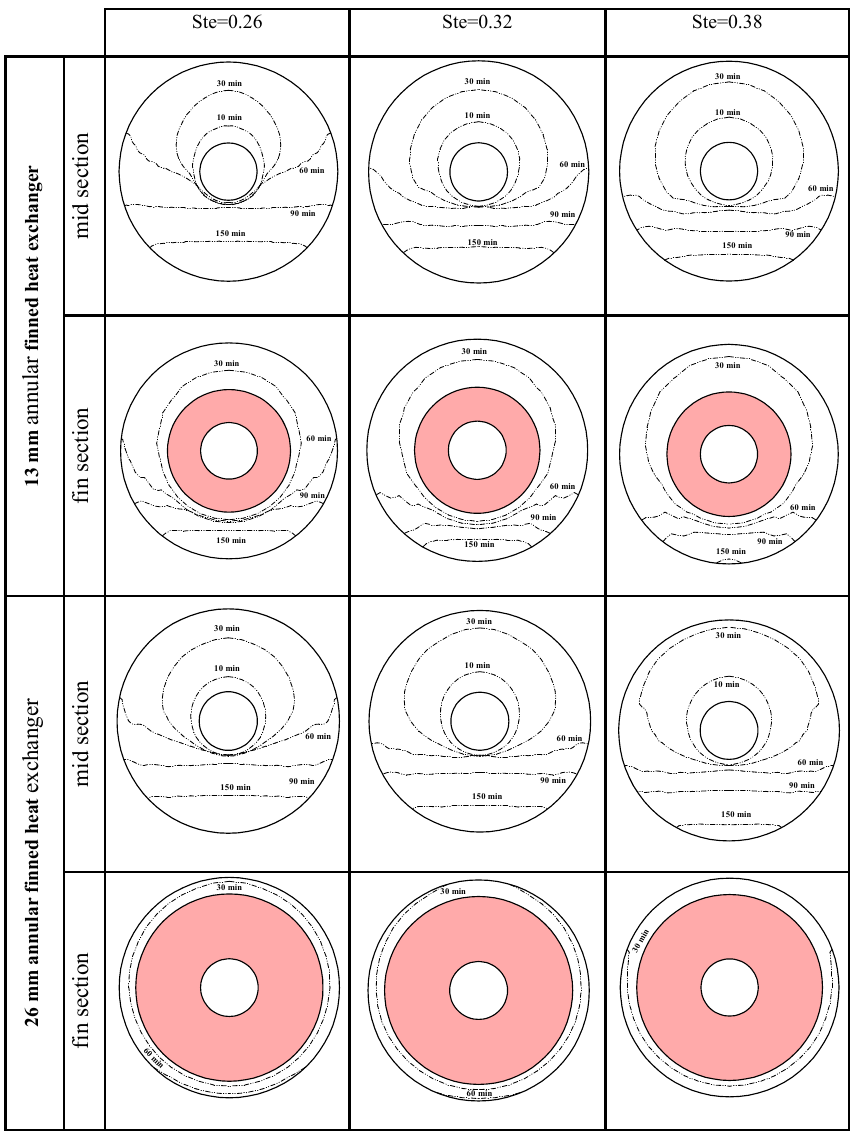
Figure 7. Numerical results showing melting front in shell for different Stefan numbers in 13 and 26mm fins’ height at mid section and fin